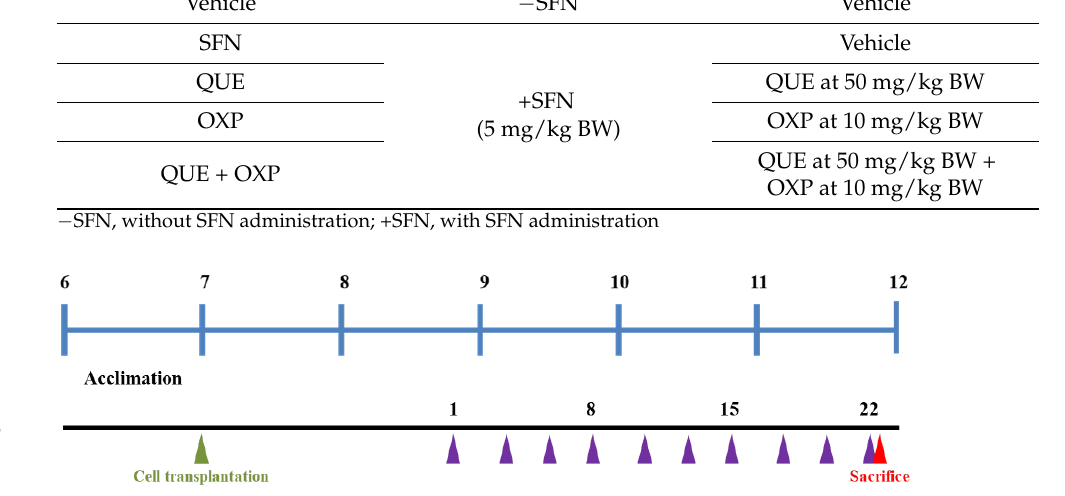
Figure 1. Animal experimental scheme. HCT116 xenograft mice were generated by subcutaneous transplantation (green triangle) in BALB/c nude mice, and treatment doses were intraperitoneally administered three times a week for three weeks (purple triangles, denoting the points at which samples were administered). The size of each xenografted tumor was regularly measured using a caliper until sacrifice (red triangle).